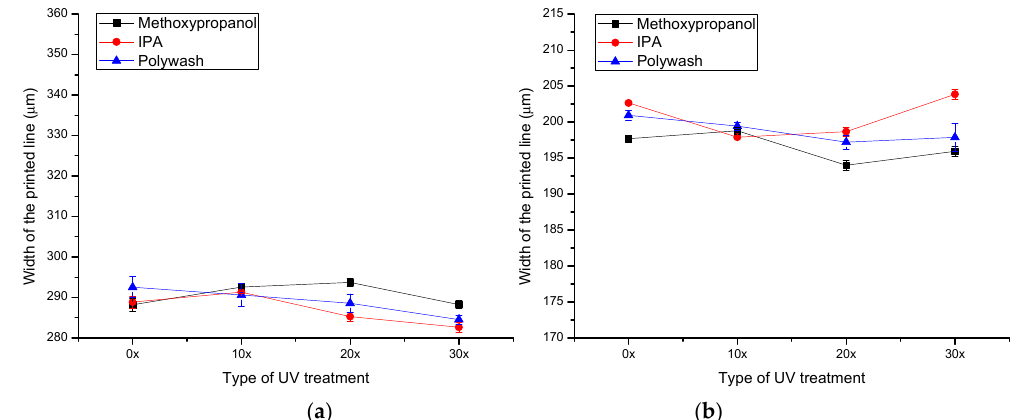
Figure 19. Width of the lines printed by modified EPDM plates: ( a ) 0.2 mm positive, ( b ) 0.2 mm negative.